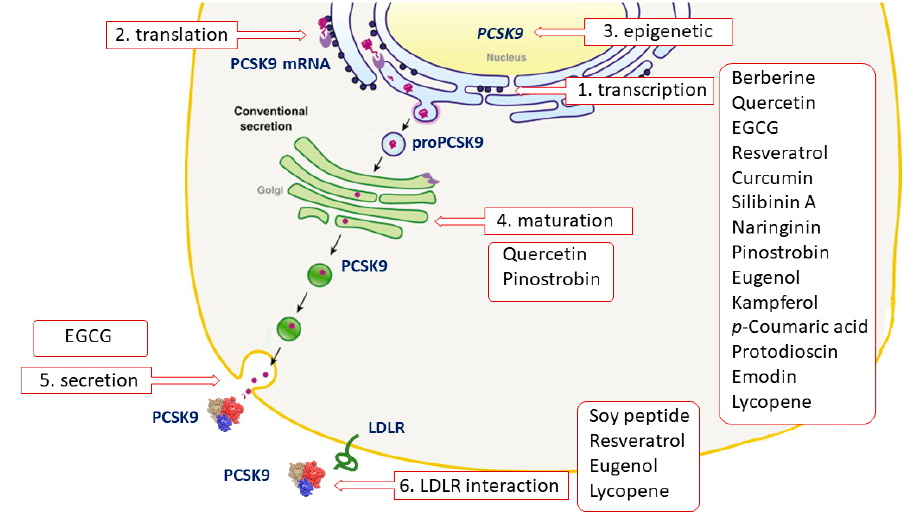
Figure 1. Schematic representation of the to-date-known mechanism of action of natural Proprotein convertase subtilisin / kexin type 9 (PCSK9) inhibitors.